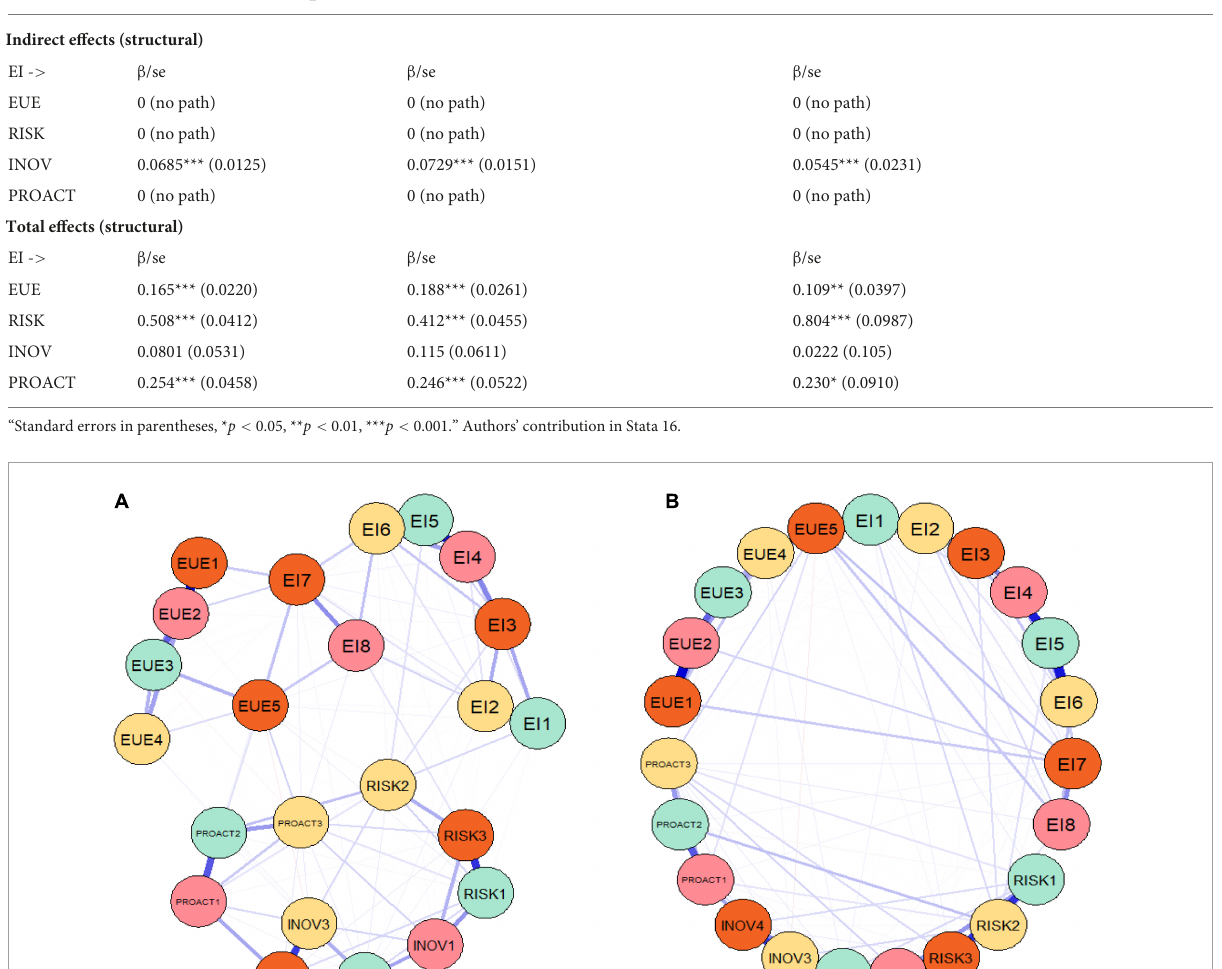
Hence, the indirect and total effects are also captured in this